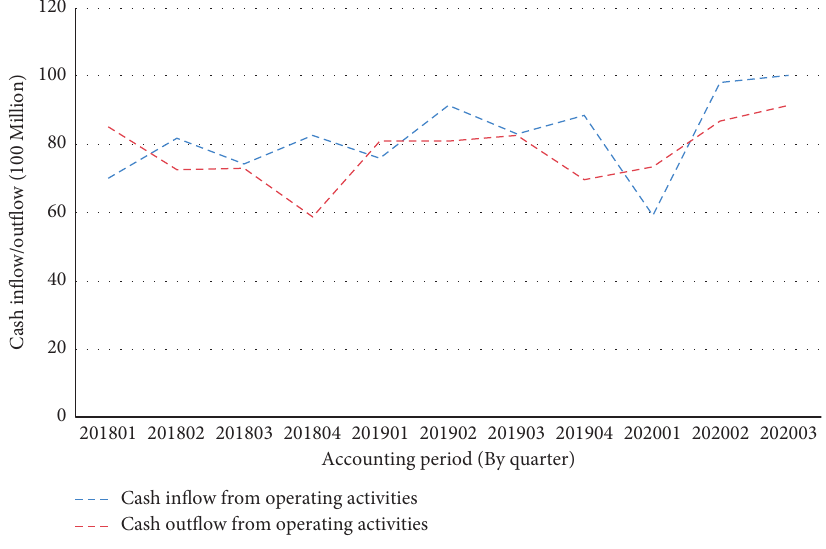
Figure 8: Changes in cash inflows/outflows from operating activities of sample